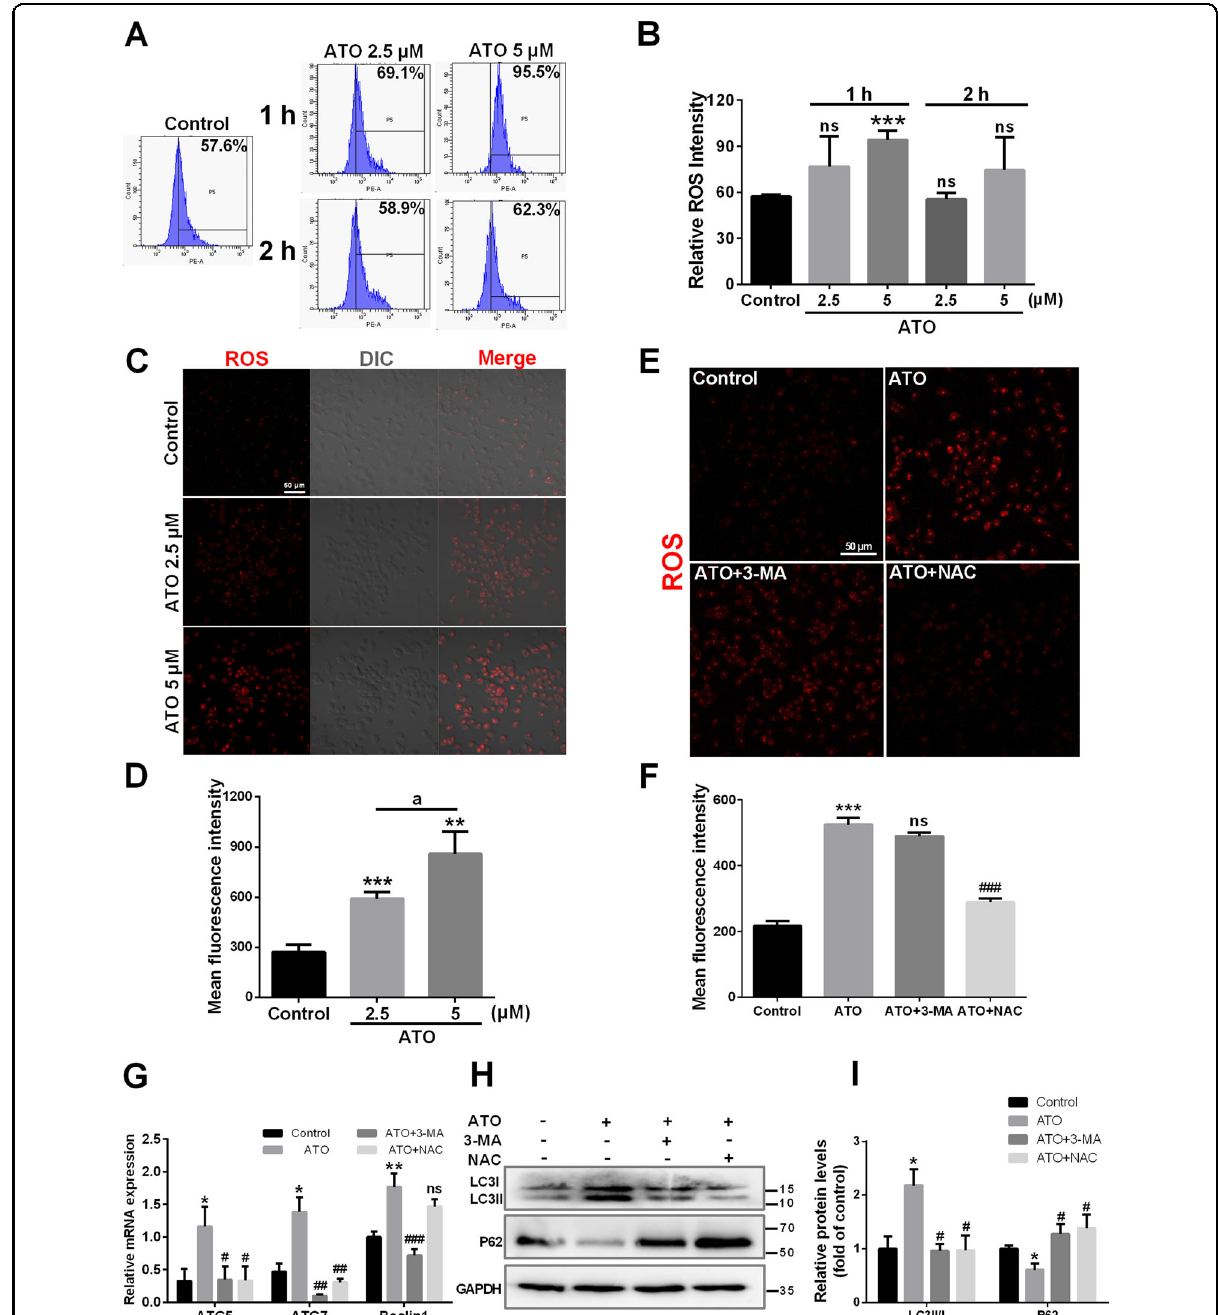
Fig. 3 ROS contribute to ATO-induced autophagy in macrophages. A , B RAW264.7 cells were treated with two concentrations of ATO (2.5, 5 μ M) for 1 h and 2 h. The relative fl uorescence intensity for ROS generation was analyzed by fl ow cytometry. C , D Fluorescence microscopy images of ROS generation in RAW264.7 cells after treated with ATO (2.5, 5 μ M) for 1 h. Scale bars = 50 μ m. a p < 0.05 vs. speci fi ed group. E – I RAW264.7 cells were treated with or without 3-MA(2.5 mM) or NAC (5 mM) followed by ATO (2.5 μ M) for 2 h. E , F Fluorescence microscopy images of ROS generation in RAW264.7 cells in the presence of NAC or 3-MA following ATO treatment. Scale bars = 50 μ m. G RT-qPCR analysis of ROS effect on autophagy via detecting speci fi c autophagy genes including Atg5 , Atg7 and Beclin 1 following incubate treatment. * p vs. the Control group, # p vs. the ATO group. H , I WB analysis of ROS effect on autophagy via detecting autopahgy speci fi c proteins LC3 and P62 following incubate treatments. Data were expressed as mean ± SD from 3 independent experiments. * p < 0.05, ** p < 0.01, *** p < 0.001, and ns means non-signi fi